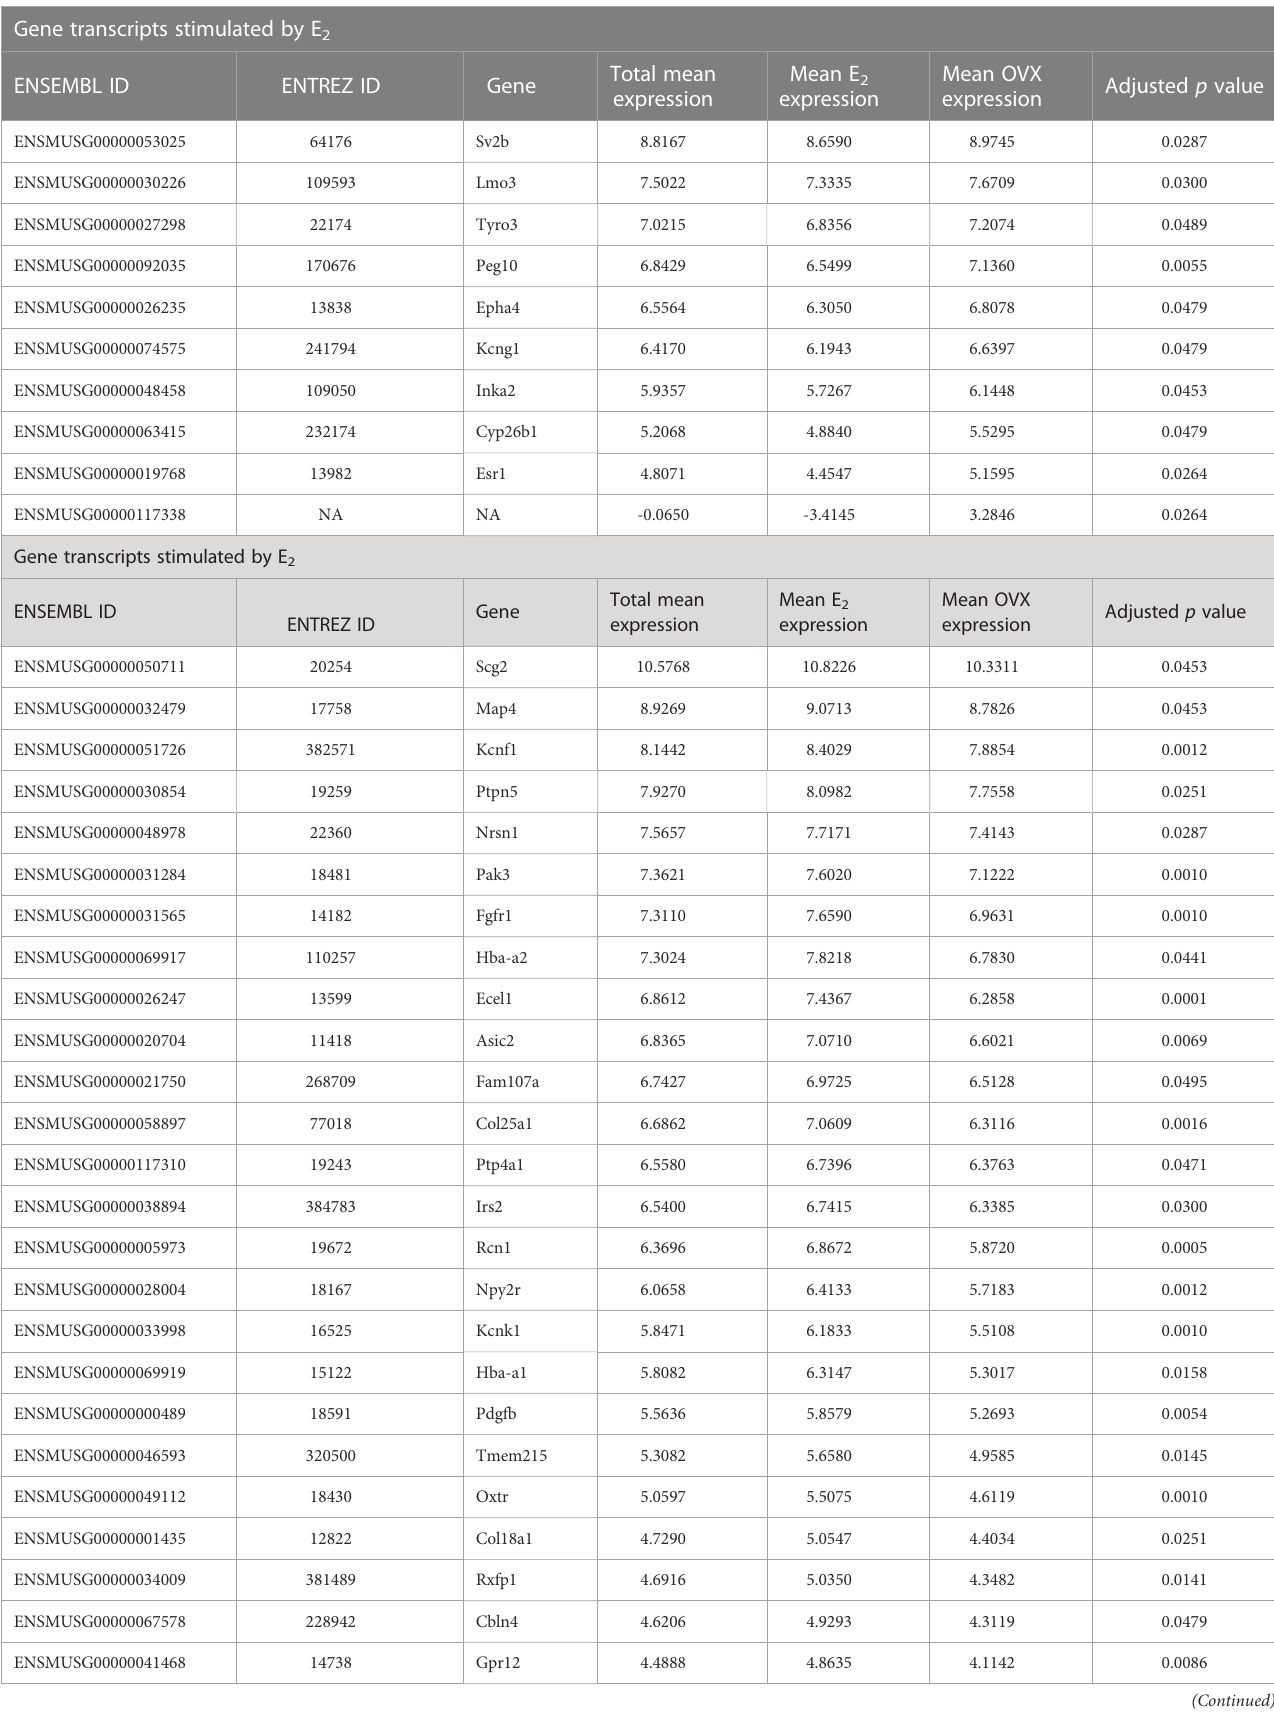
TABLE 4 The 45 gene transcripts in MeA Kiss1 cells that are differentially expressed due to estrogen treatment (E 2 vs OVX). Gene transcripts stimulated by E